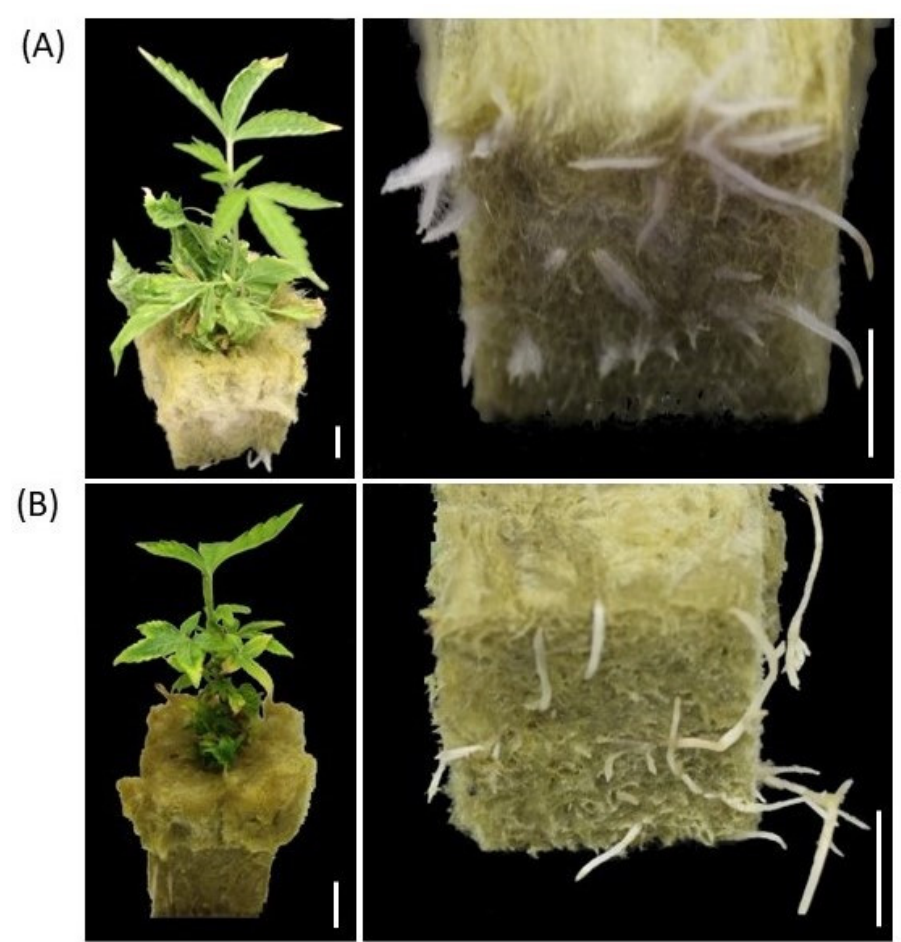
Figure 5. Germination of synseeds. Rooted plants originated either from synseeds that were stored for 90 days under 50 μ mol s − 1 m − 2 light, 18/6 h photoperiod at 6 °C and regrown on MS medium